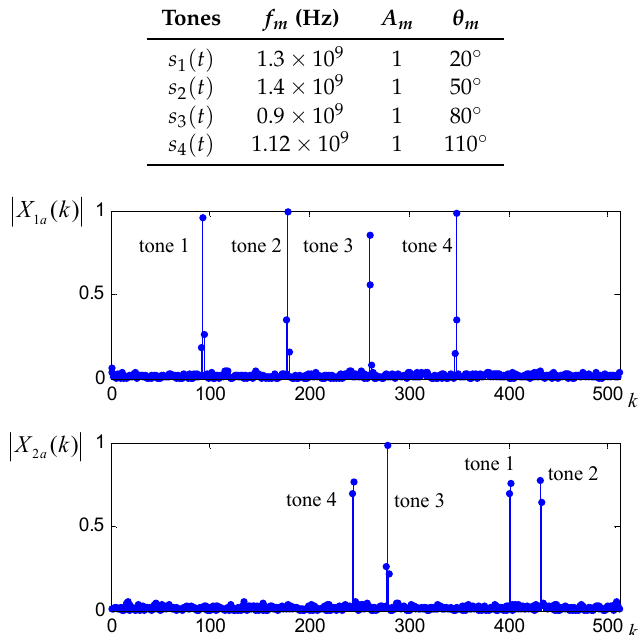
Table 1. Harmonic parameters of the multi-tone signal.